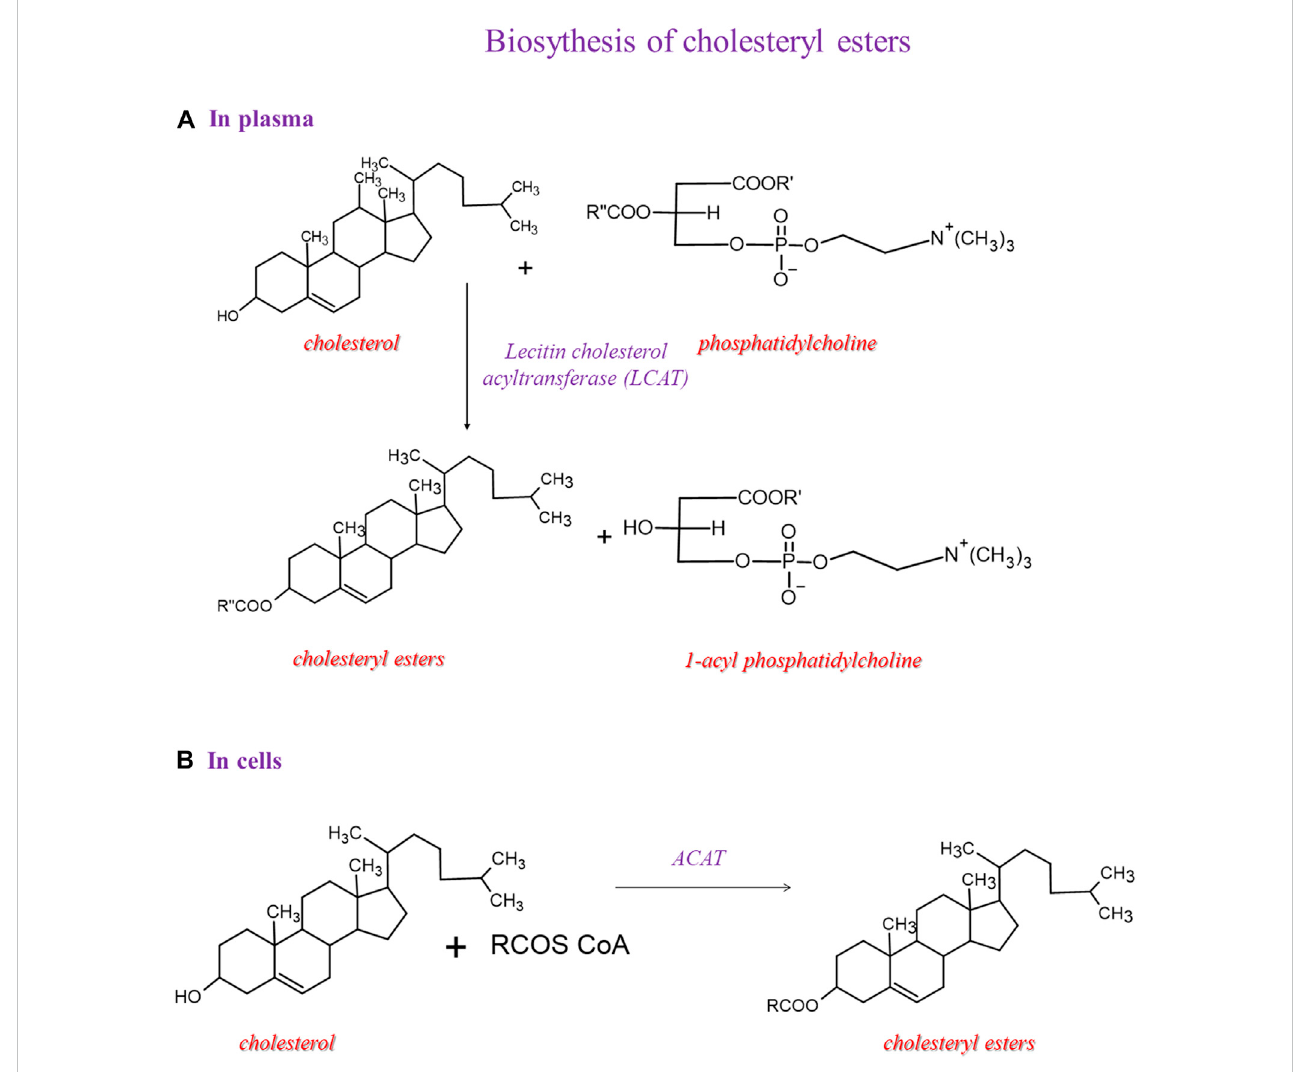
FIGURE 4 Biosynthesis of cholesteryl esters and then we showed 2 pathways: one in plasma and another in the cell.